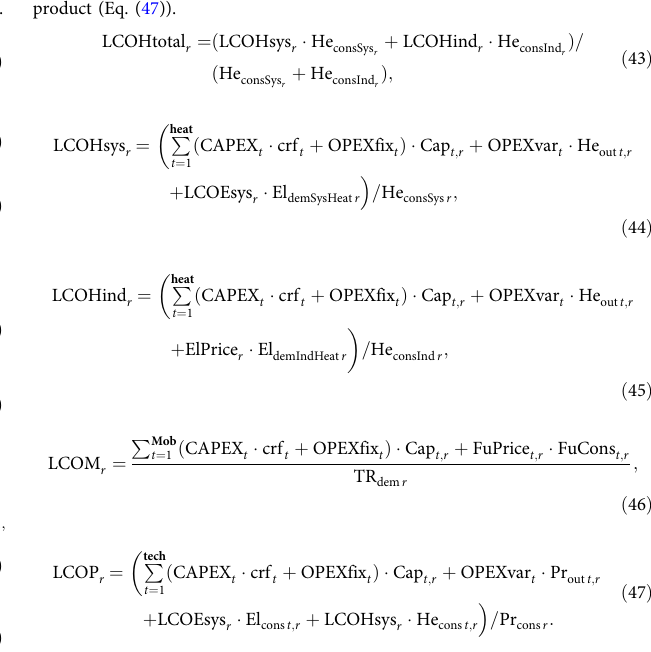
Abbreviations: region ( r ), total levelized cost of heat in the system (LCOHtotal), centralized system levelized cost of heat (LCOEsys), individual heat sector